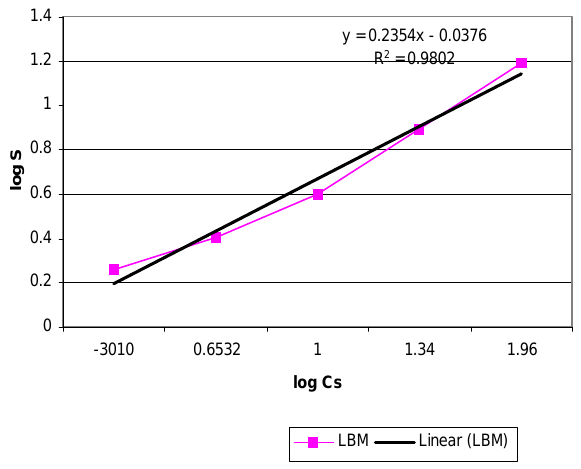
Figure 9: Freundlich Adsorption Isotherm for Batch Study for using FBM